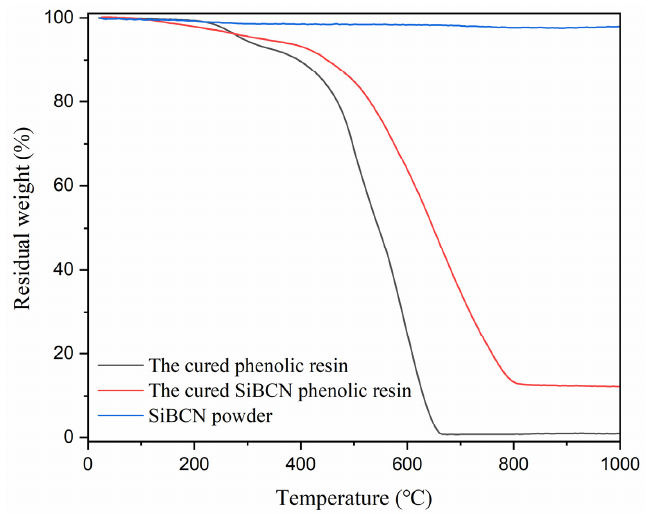
Figure 5. TG curves of the cured phenolic resins and the cured SiBCN phenolic resins in air atmosphere .